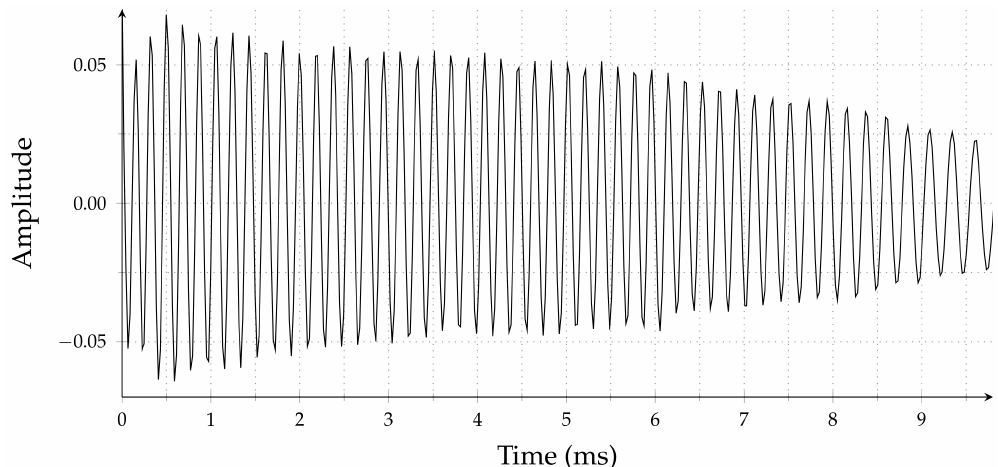
Figure 2. Measured beat signal for a coaxial cable-based delay line with 10dB attenuator, f ADC = 44.1kHz, and a chirp duration of